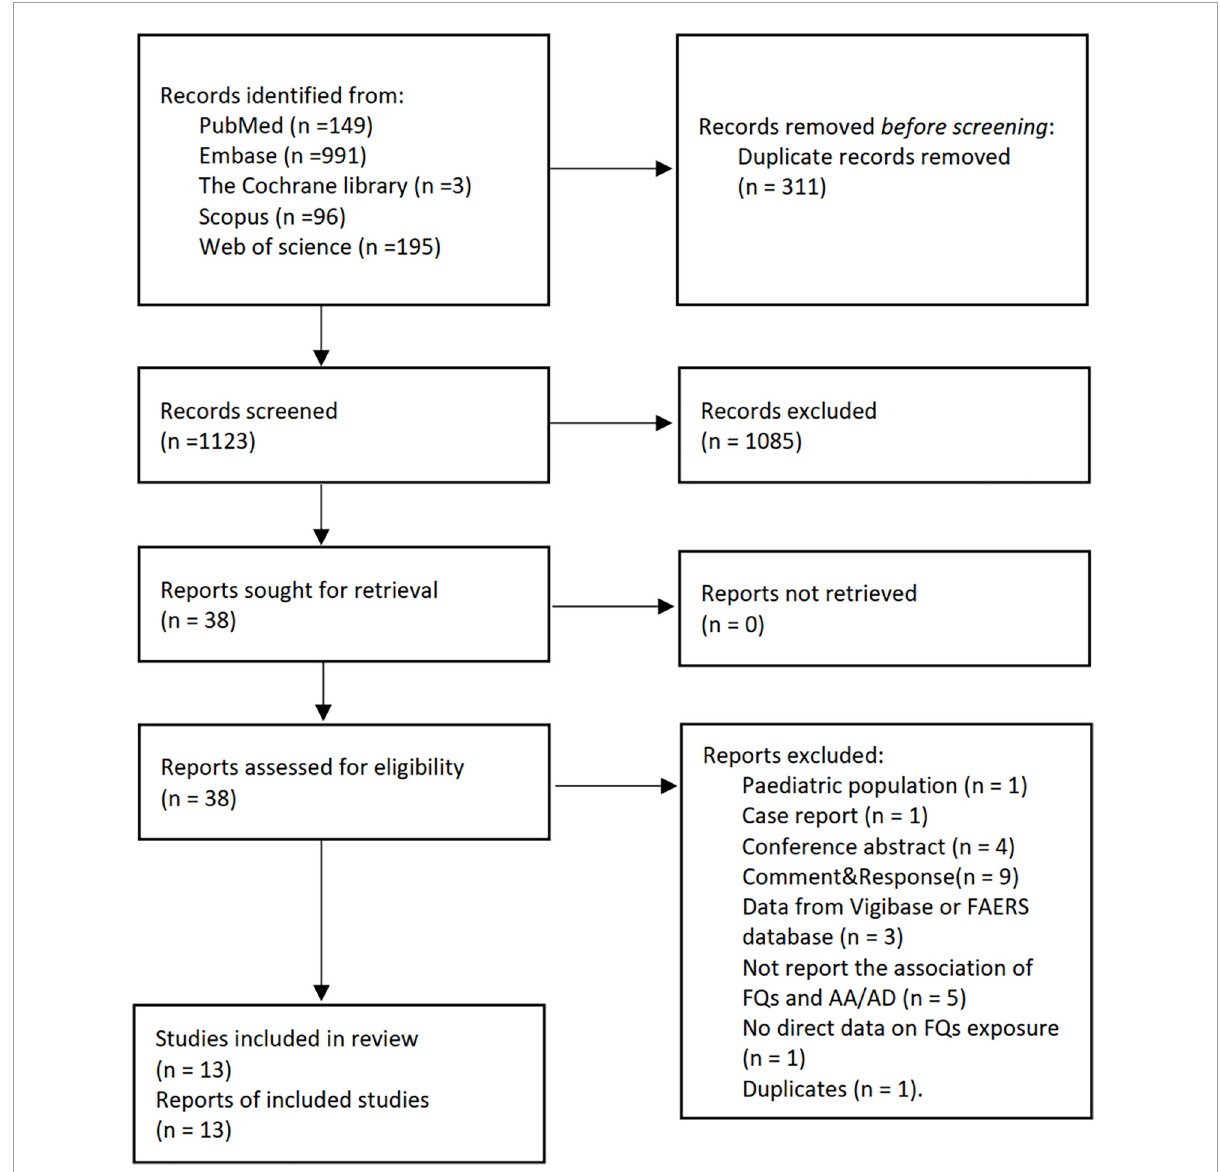
FIGURE1 The PRISMA flow diagram for literature screening. FQs, fluoroquinolones; AA, aortic aneurysm; AD, aortic